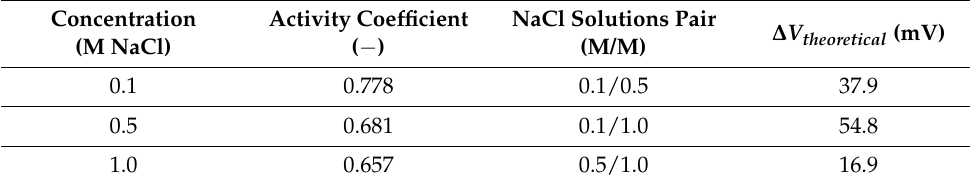
Table 1. Activity coefficient and theoretical membrane potential of the test solution pairs [27].